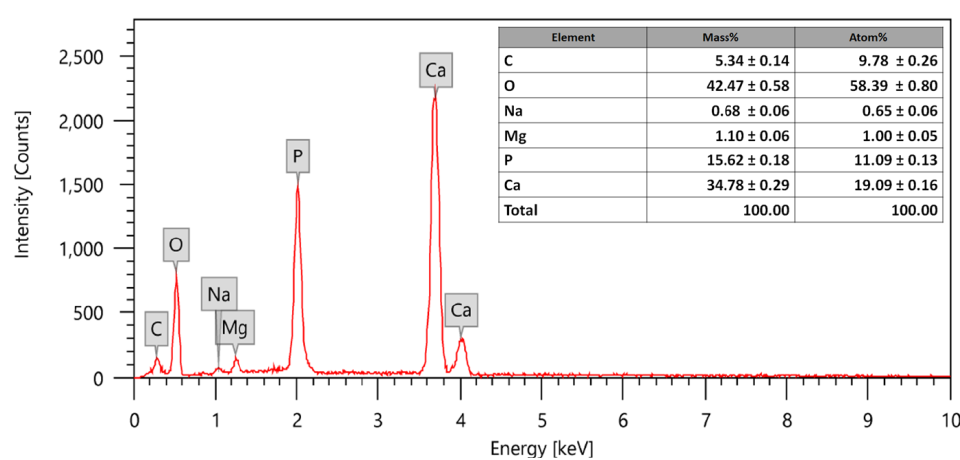
Figure 3. EDX analysis of the prepared nanohydroxyapatite powder.